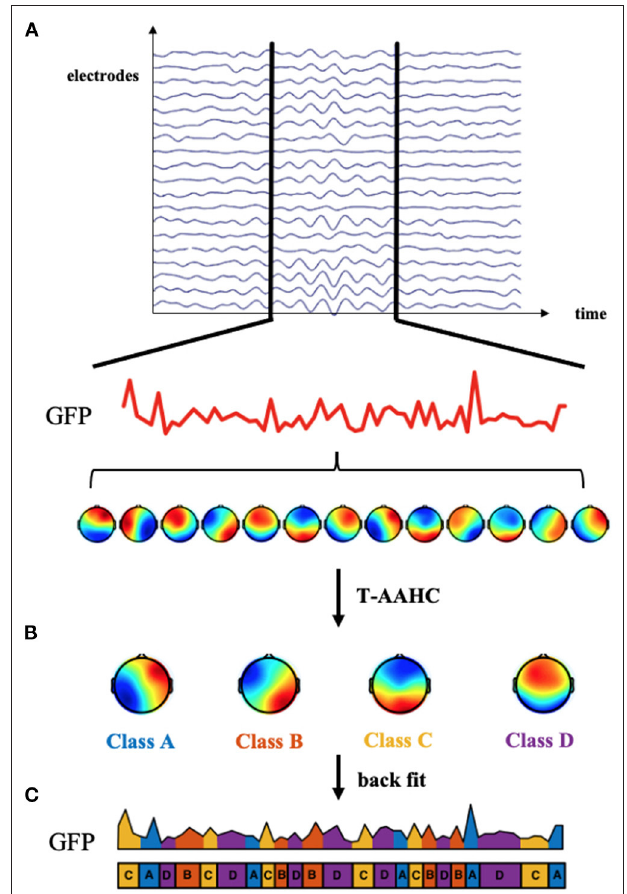
FIGURE 1 | Microstate analysis methods. (A) The global field power (GFP) was computed at each time point. The topographies of electric potential at peaks of the GFP curve were extracted because GFP peaks have the highest signal-to-noise ratio. (B) These topographies were submitted to the Topographic Atomize and Agglomerate Hierarchical Clustering Algorithm (T-AAHC). Four canonical classes labeled (A–D) were assigned to each cluster. (C) Four microstate classes were back-fitted to continuous EEG data based on the criterion of maximal spatial correlation. Then, the microstate parameters and syntax could be calculated to quantify the microstate